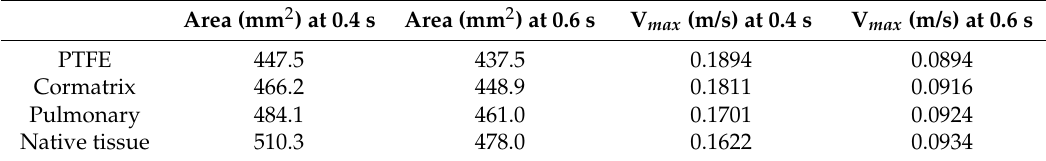
Table 3. Cross-sectional areas and peak velocities of B-B (cid:48) at 0.4 s and 0.6